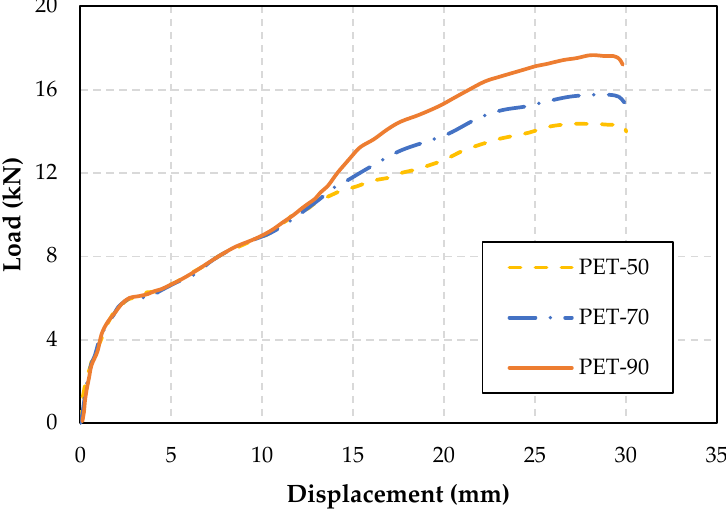
Figure 10. Effect of concrete compressive strength on the behavior of BFRP-strengthened slabs. Table 4. Numerical predicted results.